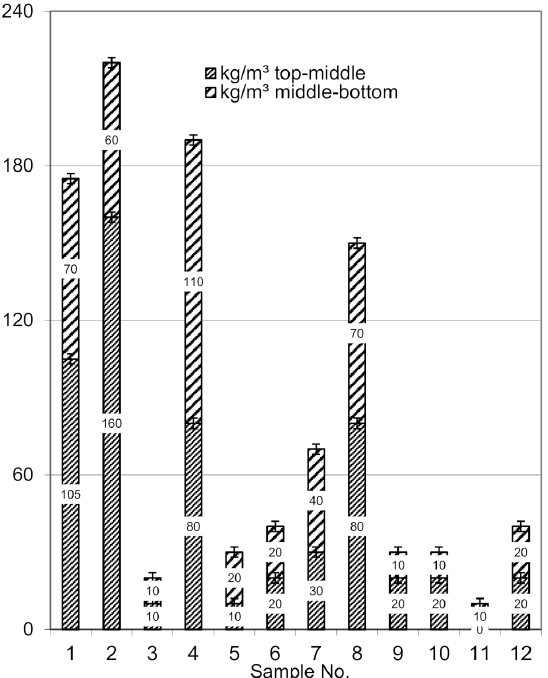
Figure 4. Density difference between the top and middle and middle and bottom of the column for the fractionation test. The measurement angle is 45 ◦